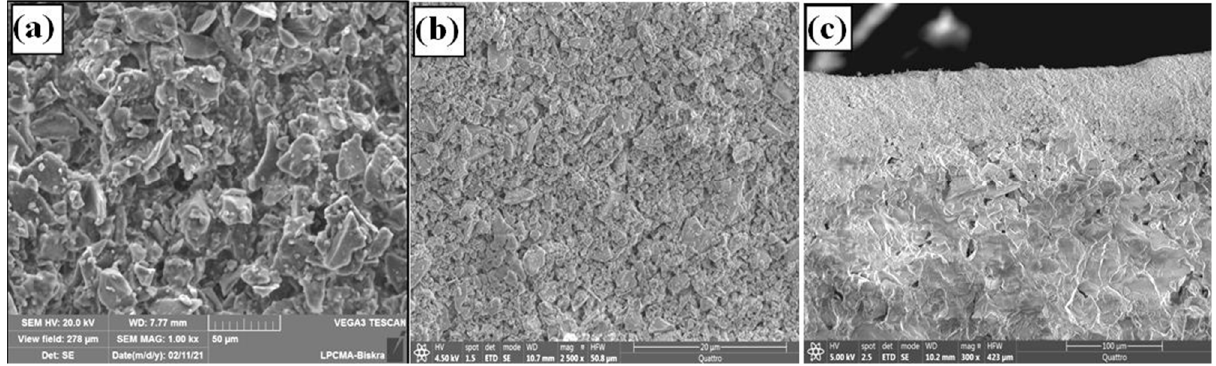
Figure 12. SEM micrographs; ( a ) surface of intermediate layer, ( b ) surface of a top layer ( c ), cross- section of the multilayer system.